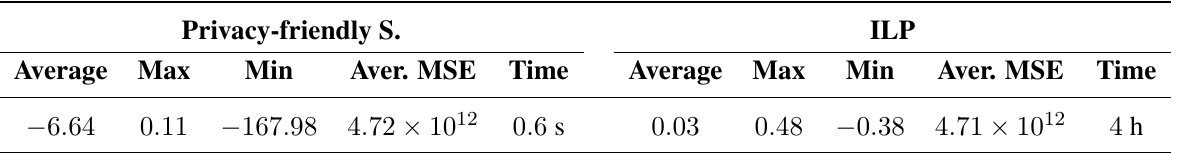
Table 5. Comparison of the performance of ILP vs. privacy-friendly